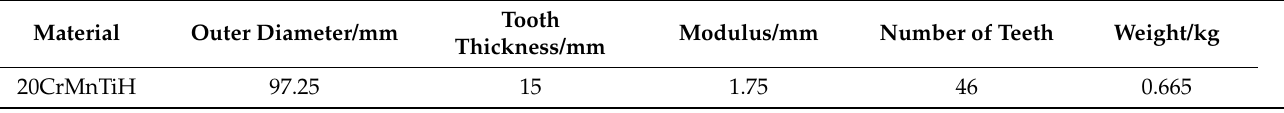
Table 1. Gear parameters.